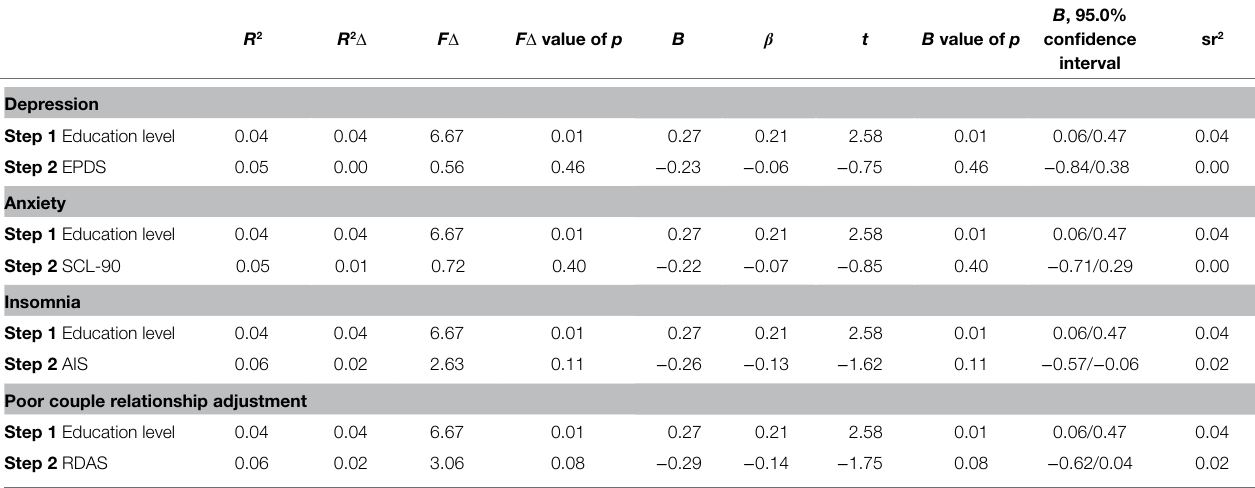
TABLE 5 | Associations between single elevated symptom domains and executive